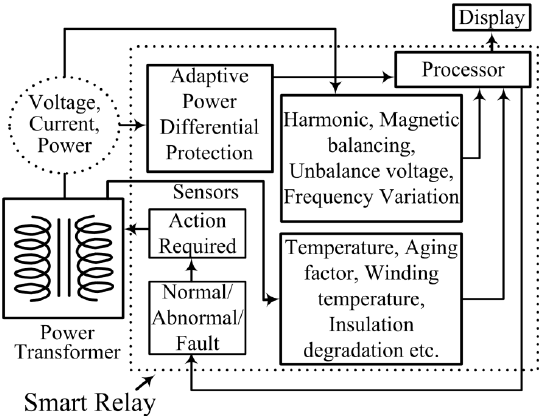
Fig. 1. Generalized schematic diagram for transformer monitoring and protection.